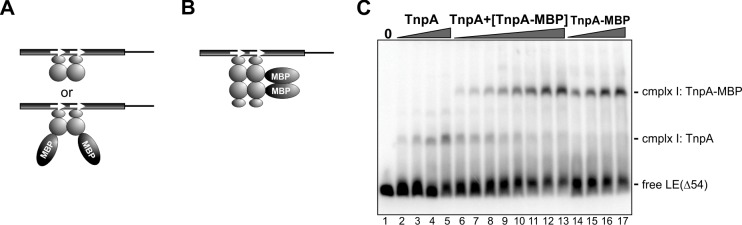
Complex I is a dimer bound to the IS1535 LE.(A) If TnpA binds as a dimer to form complex I, then either TnpA (MW 21.9 kDa) or TnpA-MBP (MW 65.5 kDa) dimeric forms would bind to motifs a and b as represented in Figure 8A to generate complex one with different electrophoretic migrations. (B) If TnpA binds to motifs a and b as a tetramer (two dimers) to form complex I, then a band of intermediate mobility consisting of the two different dimers should form, which is not observed in panel C. (C) EMSA assay on LEΔ54, which only gives complex I. In lanes 2 – 5, LEΔ54 was incubated with 8, 16, 32, and 64 nM TnpA, respectively. In lanes 14 – 17, LEΔ54 was incubated with 16, 32, 64 and 128 nM TnpA-MBP, respectively. In lanes 6 – 13, LEΔ54 was incubated with 32 nM of TnpA. plus 8 to 256 nM TnpA-MBP in 2-fold increasing amounts. No subunit mixing between dimers is evident during the time frame of the experiment.